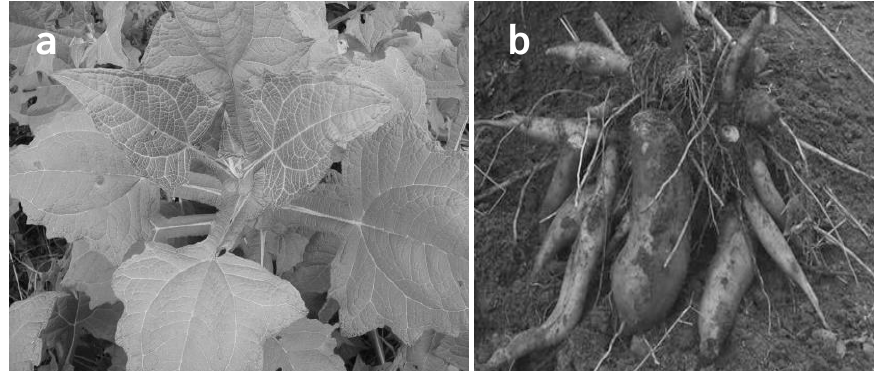
Figure 1. Yacón ( S. sonchifolius (Poepp. & Endl.), H. Rob): ( a ) aerial parts and ( b ) root parts.